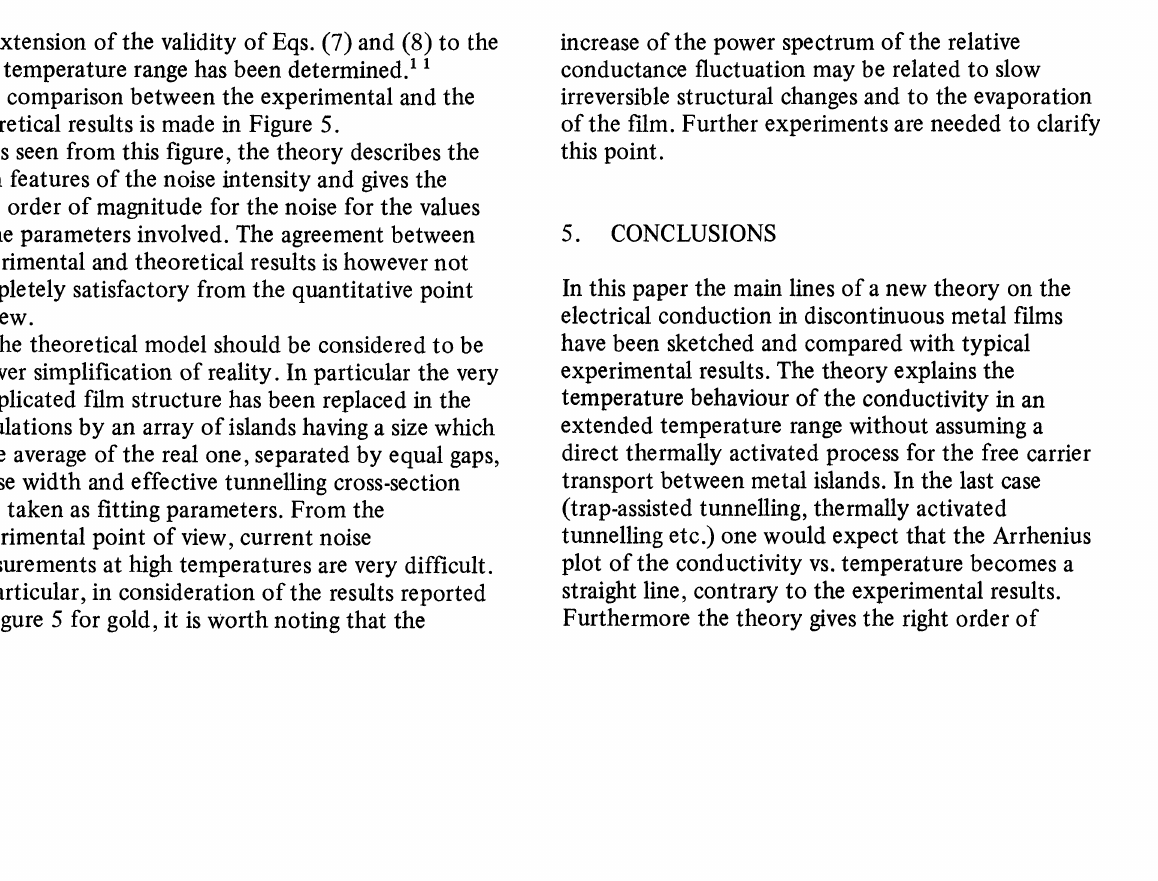
- Relative conductance noise zxG )/( G )2 and resistance vs. temperature for an Au film evaporated at 620 K in a vacuum of 10 mbar. Film dimensions are 1.0 mm x 1.0 mm The points are experimental. The broken line is computed from Eq. (14) of the paper by Celasco et al with D 6 x 10 -7 m, 2 x 10 m, B(T) has been obtained from Eq. (1) with i 1019 states/m 1 0.25 eV andd 1.3 x 10 -9 m. The integral noise has been detected in two different bands: (1) Hz to 100 kHz, (2) kHz to 100